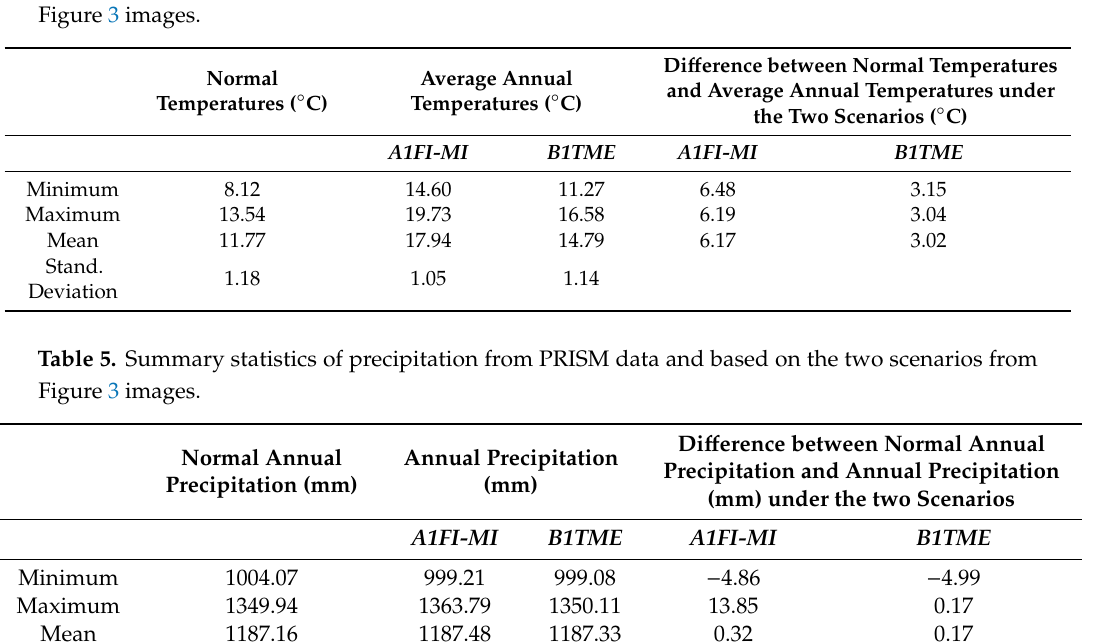
Table 4. Summary statistics of temperatures from PRISM data and based on the two scenarios from Figure 3 images.